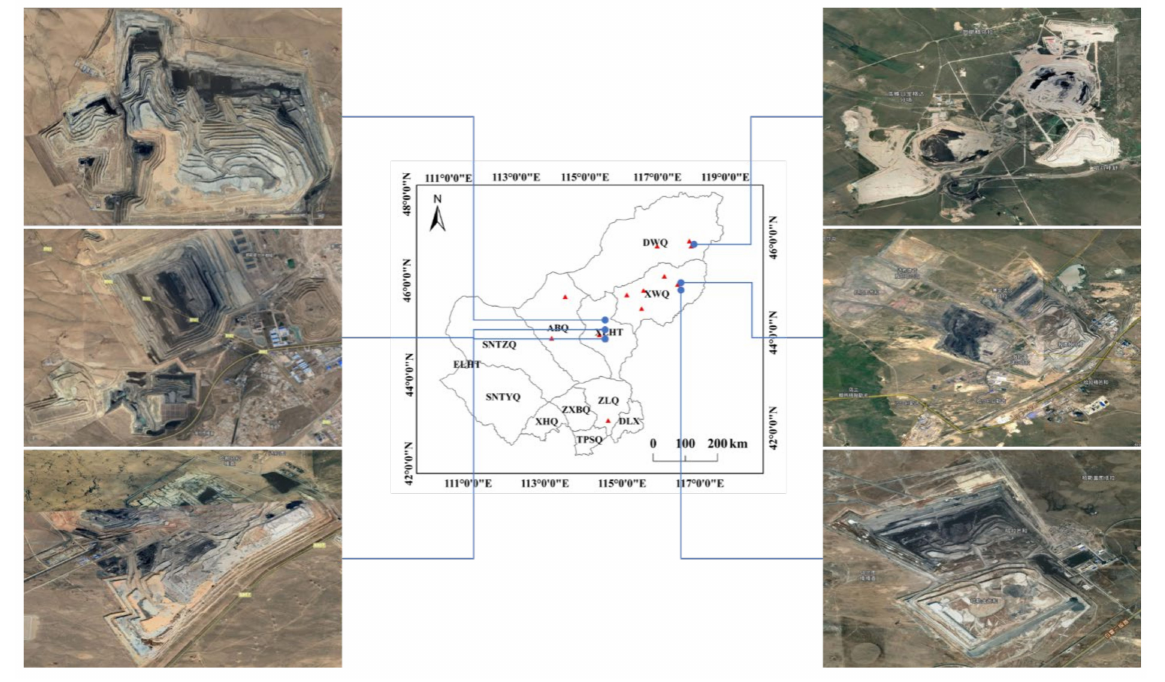
Figure 11. Image showing the main open-pit coal mining in